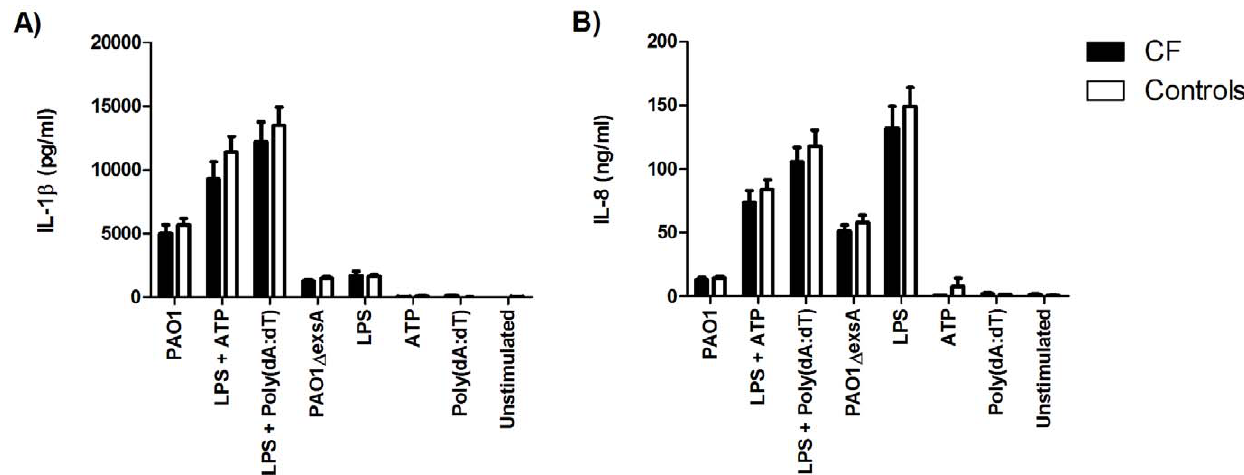
Figure 5. PBMCs from CF patients do not produce increased amounts of IL-1 b . PBMCs from CF patients (n=17–20) and healthy controls (n=15–19) were primed with LPS (10 ng/ml) overnight and stimulated with P. aeruginosa PAO1 (MOI=1), P. aeruginosa PAO1 lacking exsA (MOI=1), ATP (5 mM), or Poly(dA:dT) (1 m g/ml) for 24 hours. P. aeruginosa lacking exsA was used as a type III secretion control in comparison with wild-type P. aeruginosa . Supernatants were assayed for (A) IL-1 b and (B) IL-8.